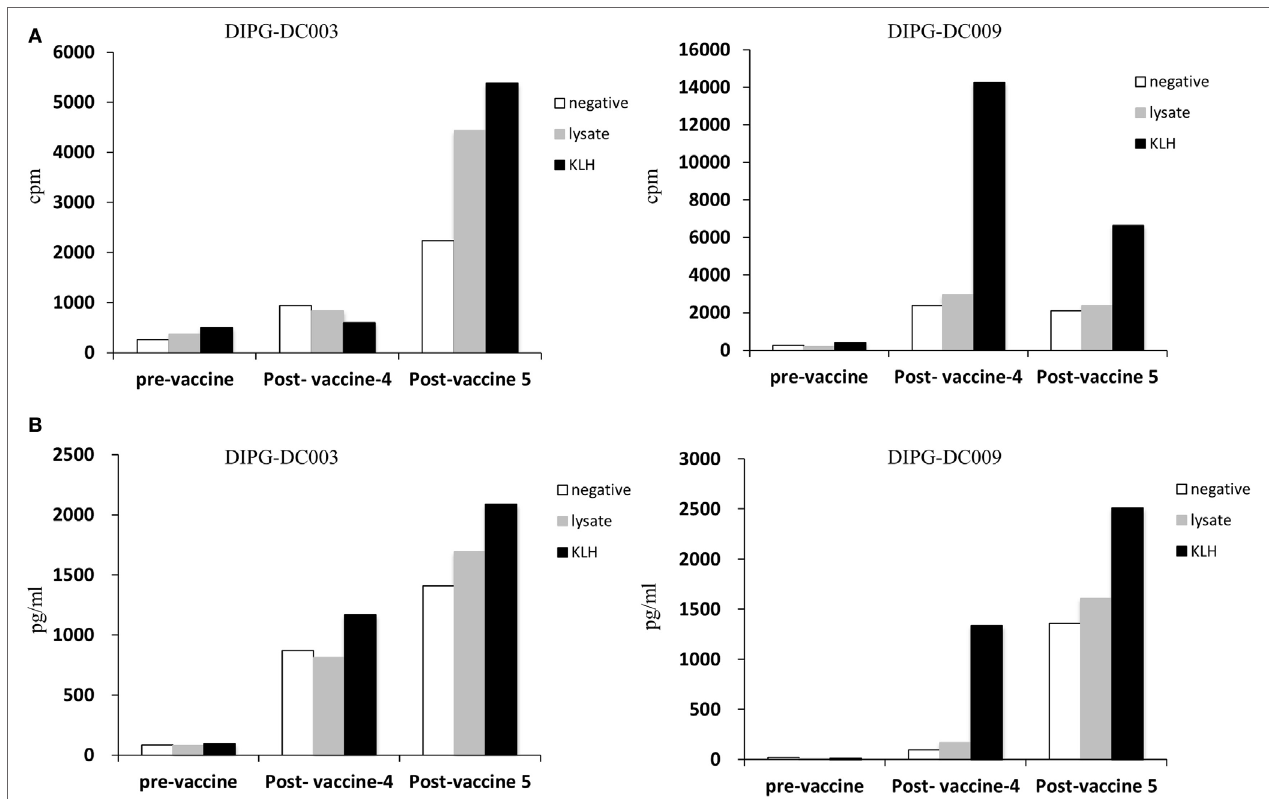
FiGUrE 4 | Isolated and expanded T-cell obtained from CFS. (a) Antigen specificity of T cell from CSF was evaluated by cell proliferation (cpm indicates thymidine incorporation; cpm = counts per million) in response to KLH or tumor cell lines lysate. (B) T cell activation was measured by cytokine production (IFN- γ ) in response to KLH or tumor cell lines lysate compared to